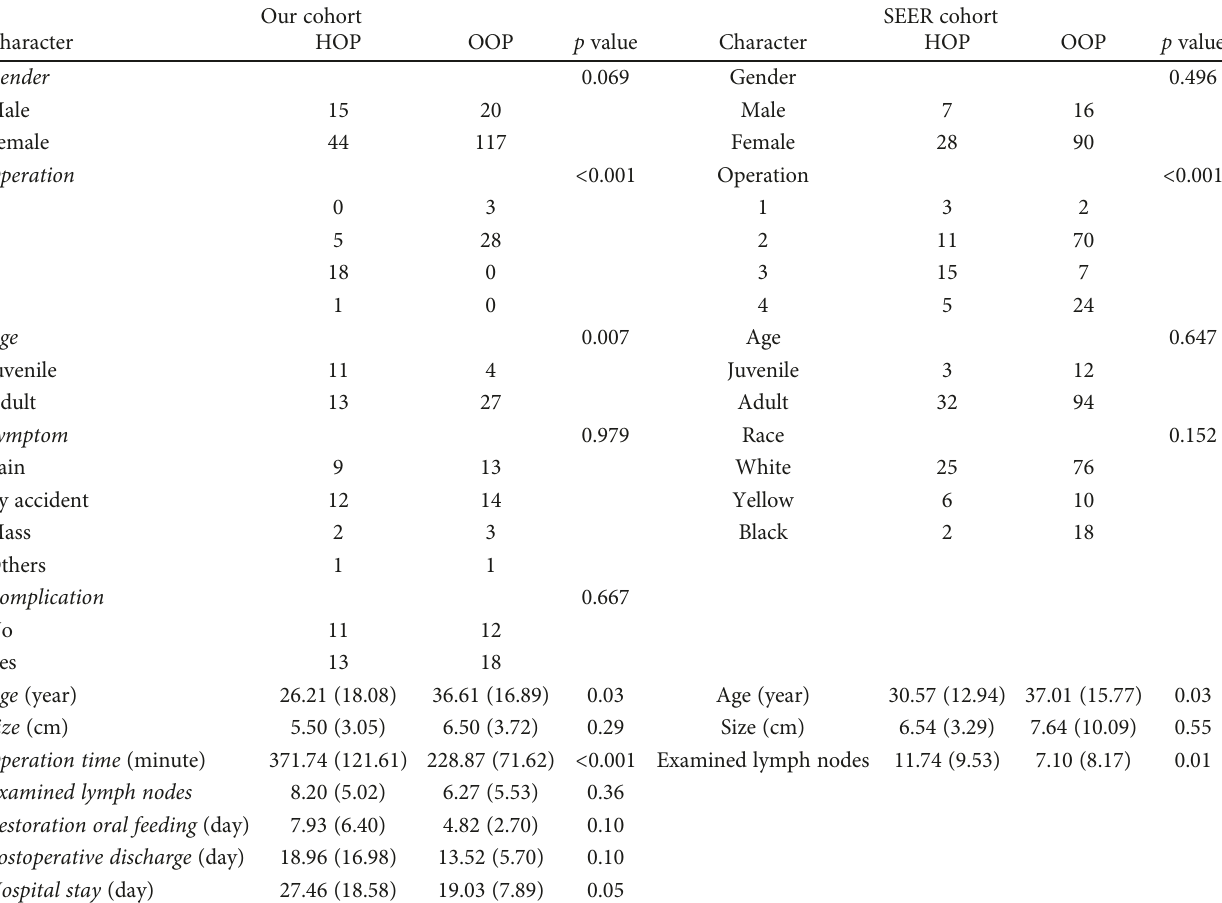
Table 4: Comparison of selected clinicopathological parameters between the HOP group and the OOP